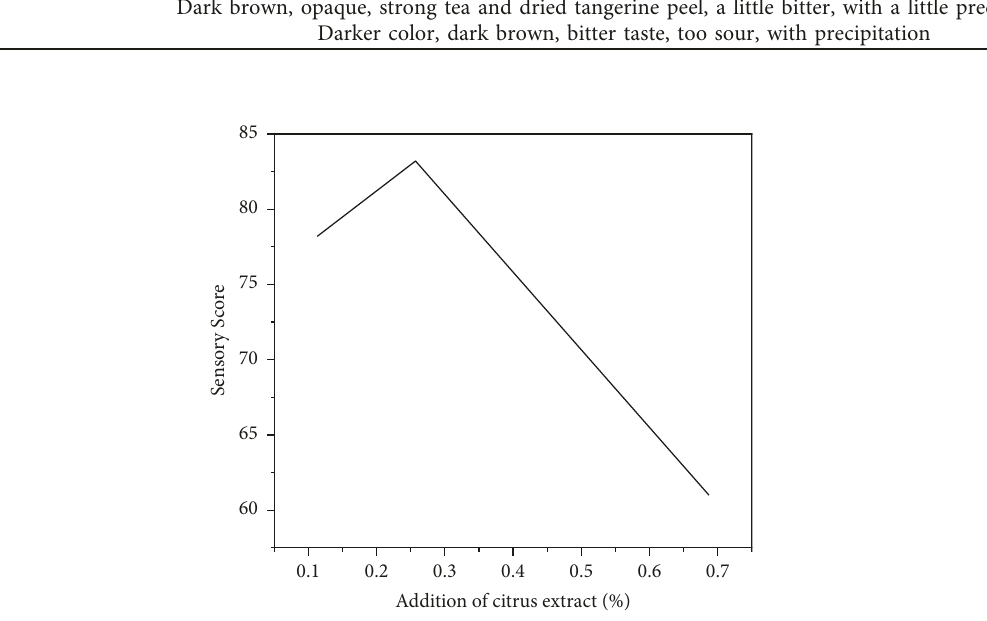
Figure 2: The effect of the additional amount of Jupu extract on the sensory quality of beverages. Table 3: Comparison of body weight, body fat percentage, fat mass, and BMI in each group before and after the experiment.